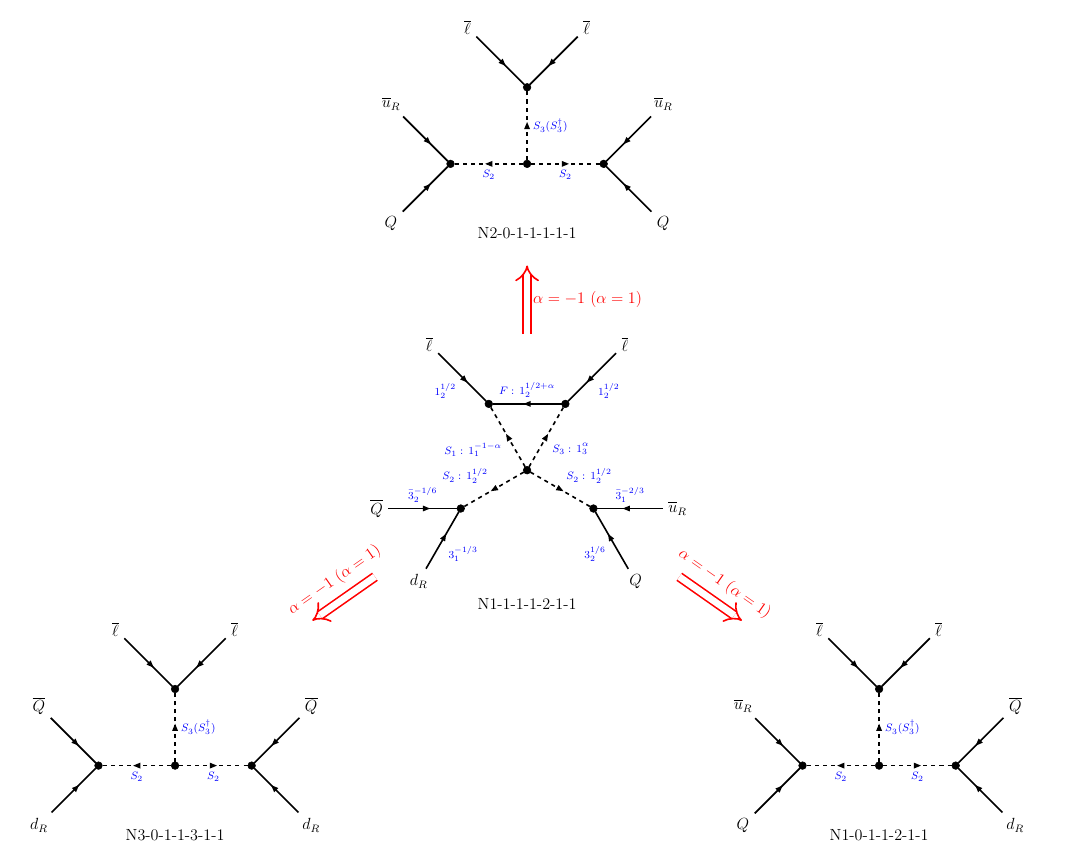
Figure 8 . One example of the non-genuine model N1-1-1-1-2-1-1, the mediators S 2 and S 3 will also lead to tree-level contributions N1-0-1-1-2-1-1, N2-0-1-1-1-1-1, N3-0-1-1-3-1-1 when the hypercharge parameter α = ± 1 . The quantum numbers are given in the notation C Y SU(3) C transformation, L refers to the SU(2) L transformation, and Y stands for U(1) Y